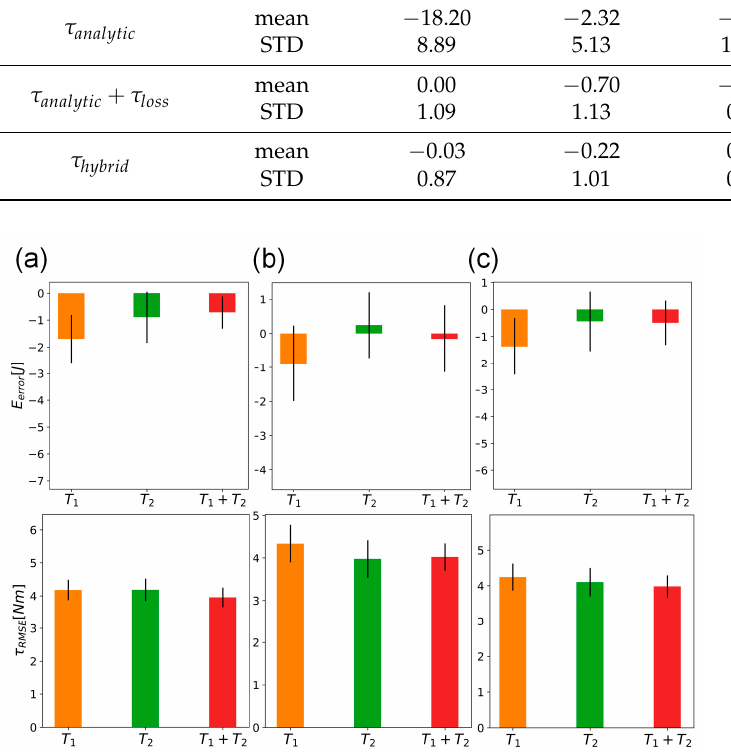
Figure 9. The errors of the manipulator energy consumption and the RMSE of the joint torques. Subfigures ( a – c ) are the results using the evaluating trajectory data groups, E1, E2, and E1 + E2, respectively. In each subfigure, three bars represent the performance of the hybrid model by training data groups T1, T2, and T1 + T2, where black lines are plus and minus one STD and colored bars are mean values.